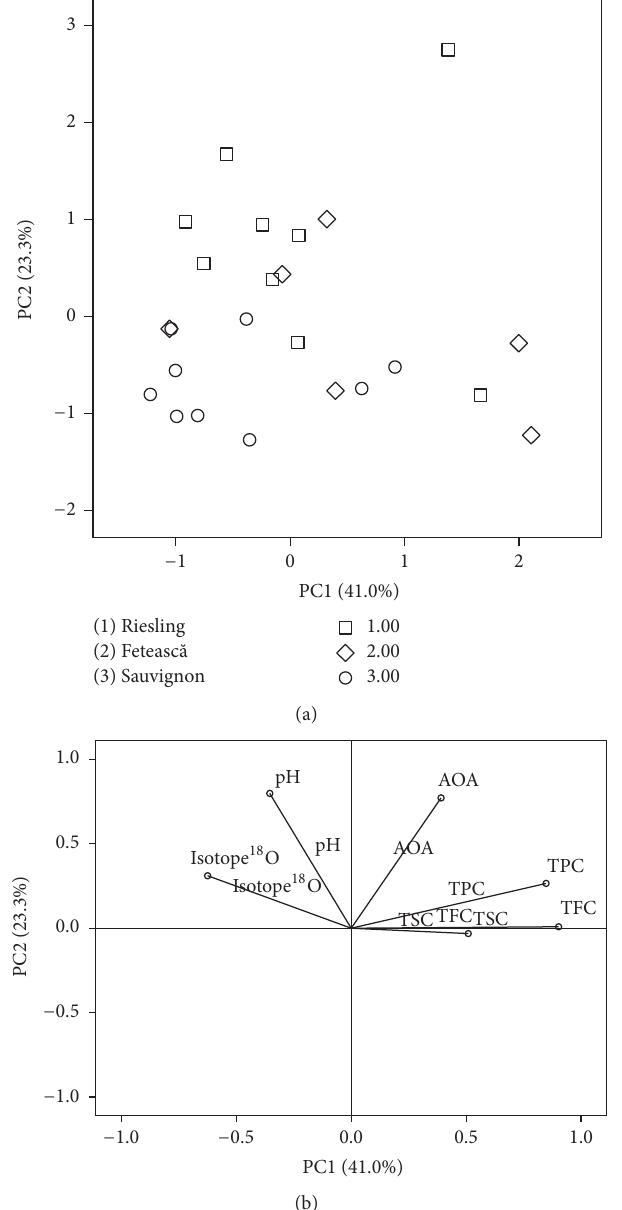
Figure 2: Score of PCA (a) and the PCA loadings (b) for the tested wine